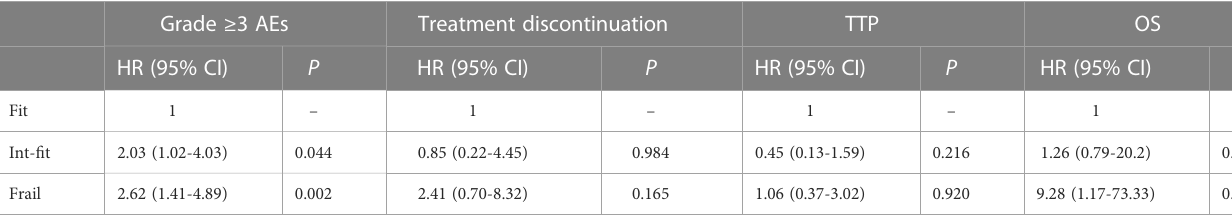
TABLE 7 Multivariate analysis of the impact of the TM frailty score in different